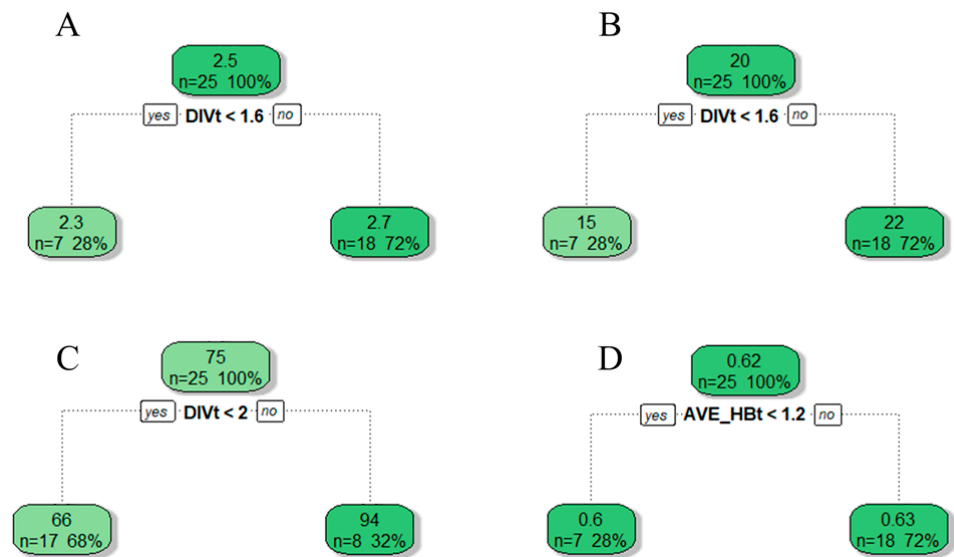
Figure 9. Relationships between bird diversity ( A ), richness ( B ), abundance ( C ), and Pielou index ( D ) of urban mountain parks based on regression tree and vegetation variables from the results of principal component analysis (PC1 to PC4). DIVt, diversity of trees; AVE_HBt, average branch height under trees.